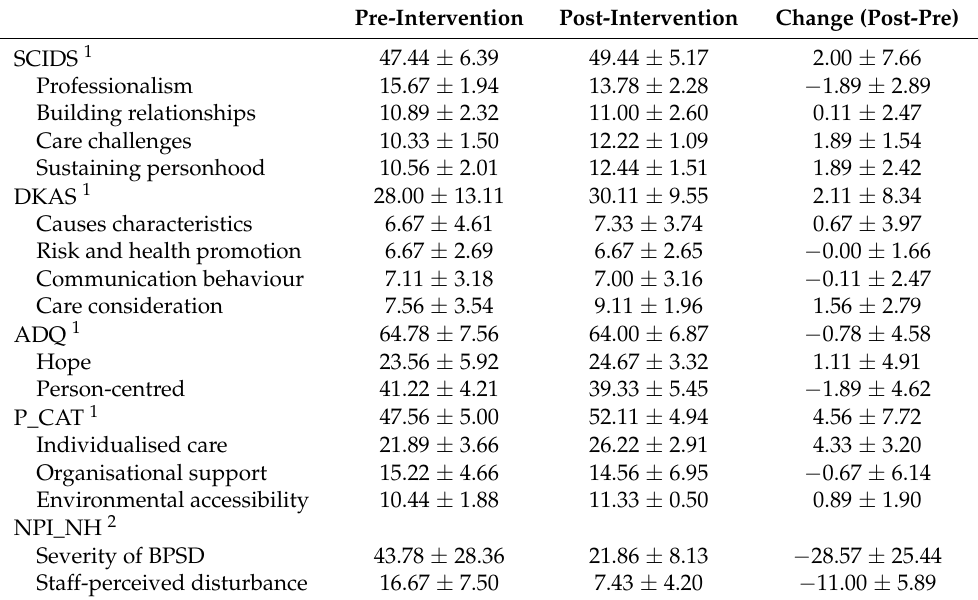
Table 1. Outcome measures at pre- and post-intervention and the changes (N = 9) (mean ± SD).